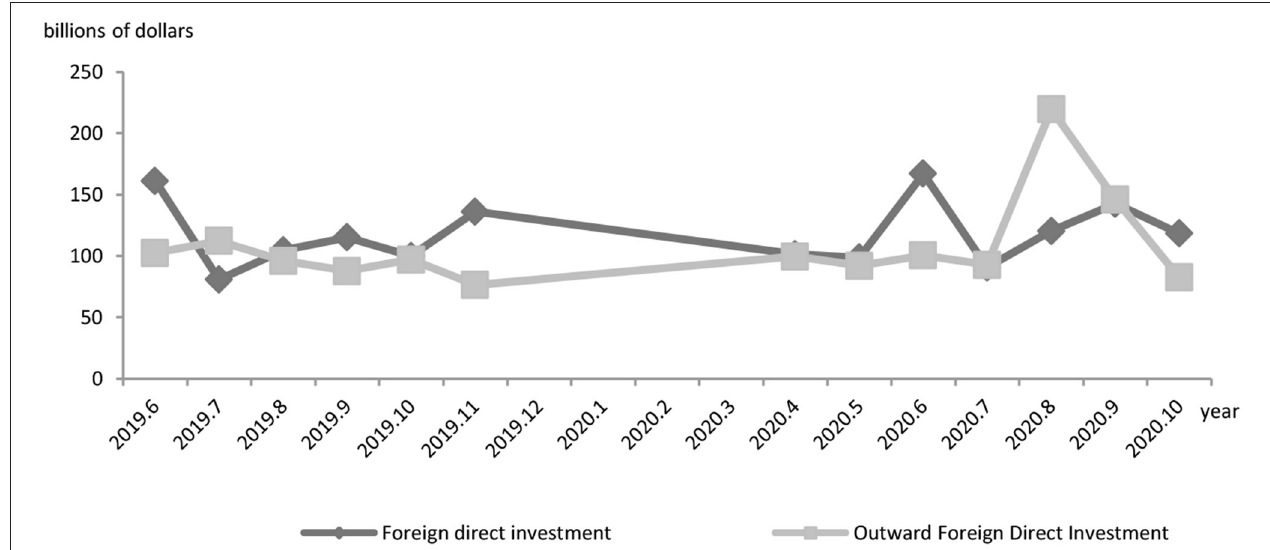
FIGURE 4 | China’s foreign direct investment and outward foreign direct investment. Data source: Ministry of Commerce of the people’s Republic of China.